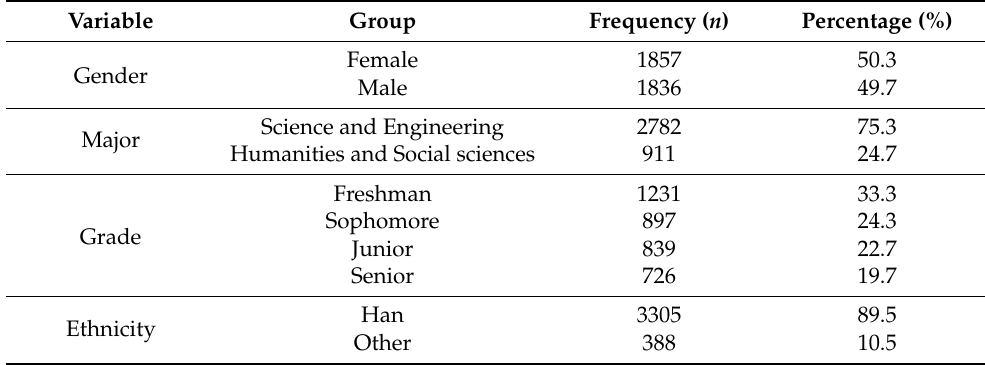
Table 1. Composition of the final